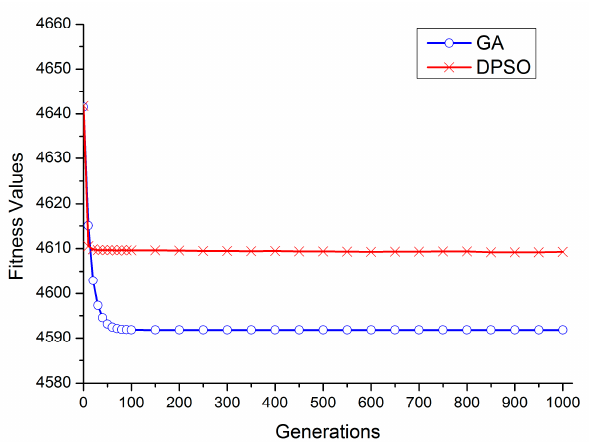
Figure 9. Fitness values of the GA and DPSO algorithm achieve over 1000 generations when n = 60.